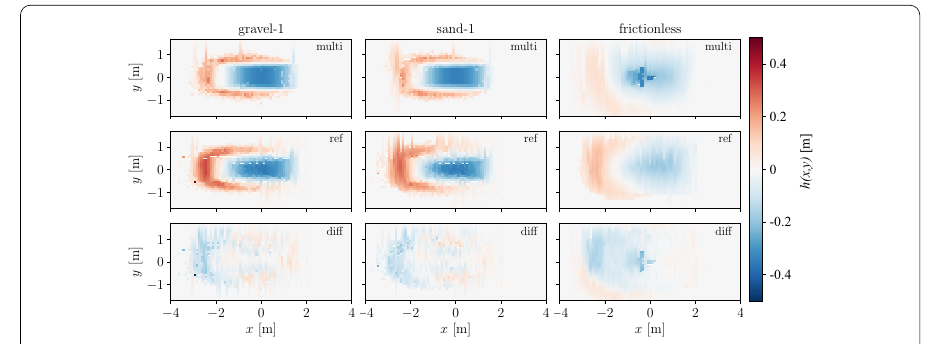
Fig. 18 The resulting surfaces from excavation in three frictional soils using the multiscale model (top row) and the microscale reference model (middle row). The difference is shown at the bottom row